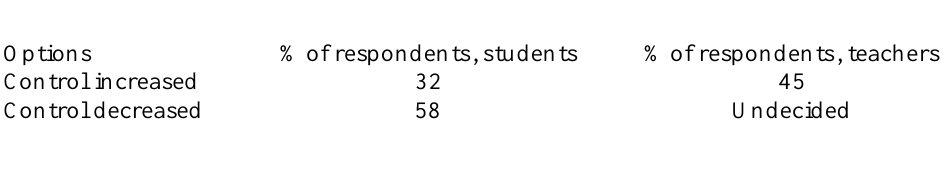
LMS as an Assessment Tool